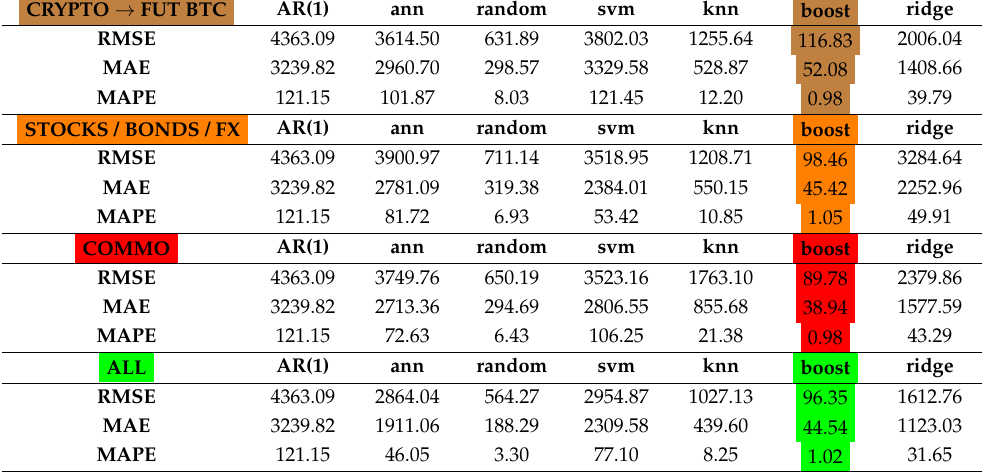
Note: AR(1) stands for the autoregressive model of order one; ann for the Artificial Neural Network model; random for the Random forest model; svm for the Support Vector Machine model; knn for the k-Nearest neighbor model; boost for the Adaboost model; and ridge for the Ridge regression. In terms of forecast statistics, we resort to the Root Mean Square Error (RMSE), the Mean Absolute Error (MAE), and the Mean Absolute Percent Error (MAPE). Table 9. Sub-sample forecasting results of CME Bitcoin Futures price during the 2016–18 economic cycle. CRYPTO → FUT